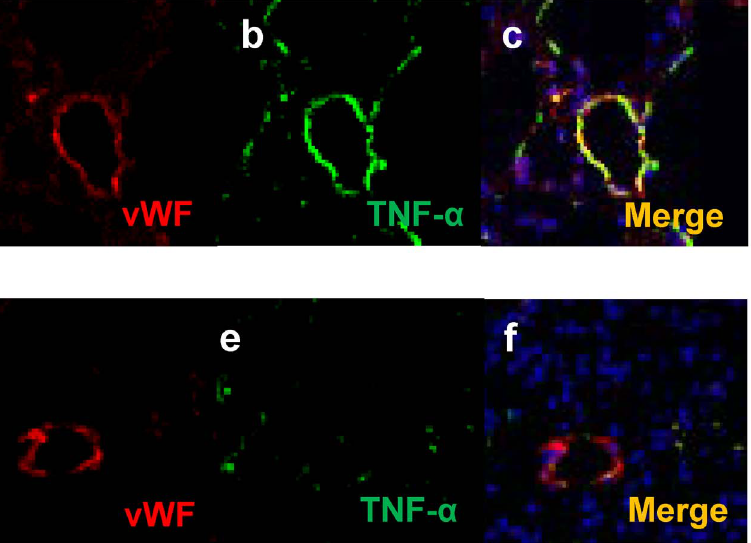
Figure 4. Immunofluorescent localization of von Willebrand factor (vWF) and tumor necrosis factor alpha (TNF- a ). Representative images of lung tissues isolated 3 weeks after the CBDL or sham procedures showing vWF (red), TNF- a (green), and DAPI, nuclear staining marker (blue). (a–c) Staining at 3 weeks after the CBDL and (d–f) sham procedures. TNF- a was more highly expressed in pulmonary endothelial vascular cells at 3 weeks after CBDL than those of the sham operated group (original magnification, 6 20).